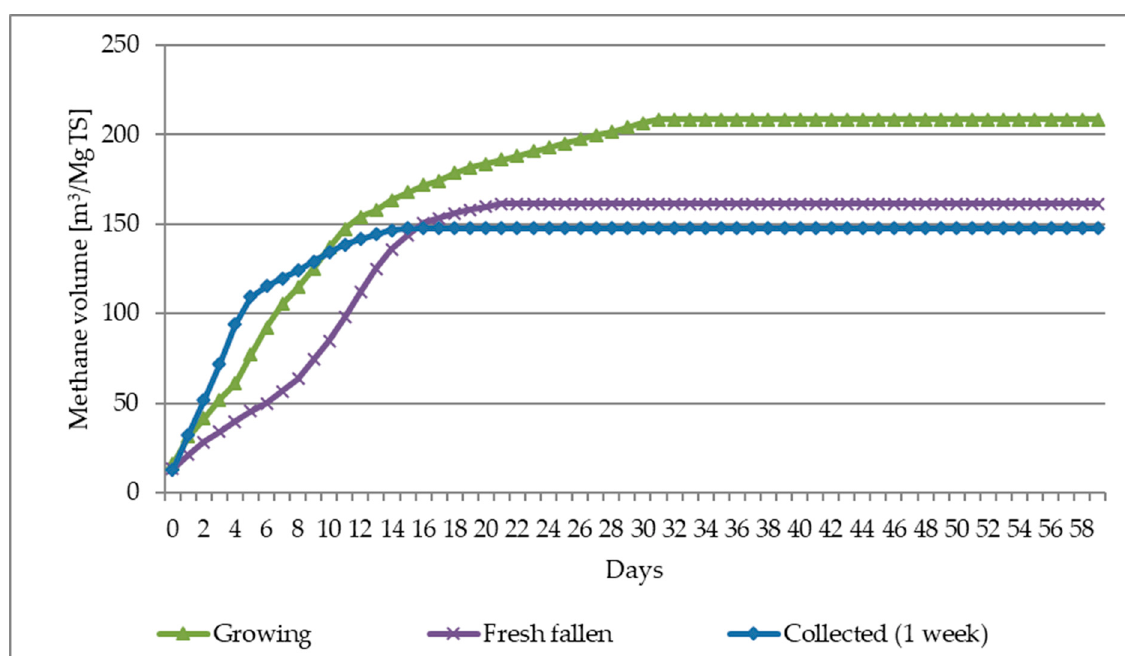
Figure 7. Biogas production from dry mass in time.